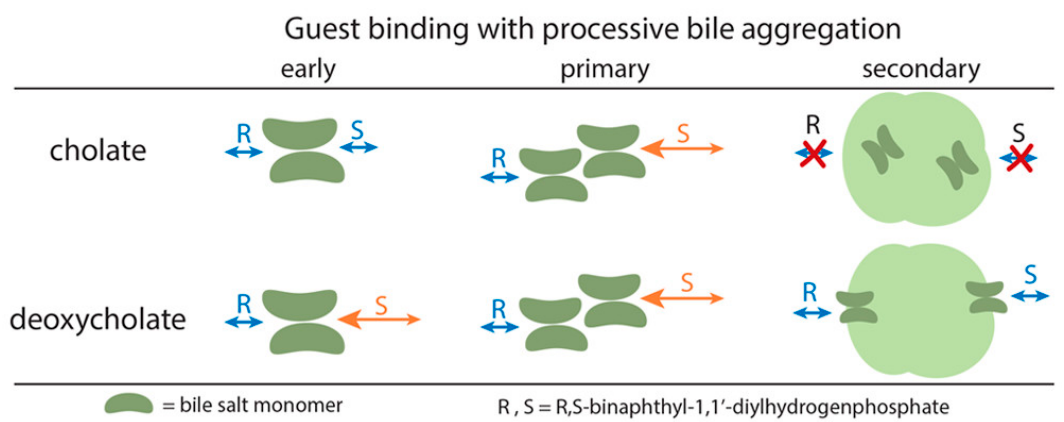
Figure 5. Schematic representation of guest binding with different bile salt aggregates. Pre-micellar or early are formed at low concentration, then primary and secondary aggregates are formed with increasing concentration of surfactant. Reprinted with permission from [75] .